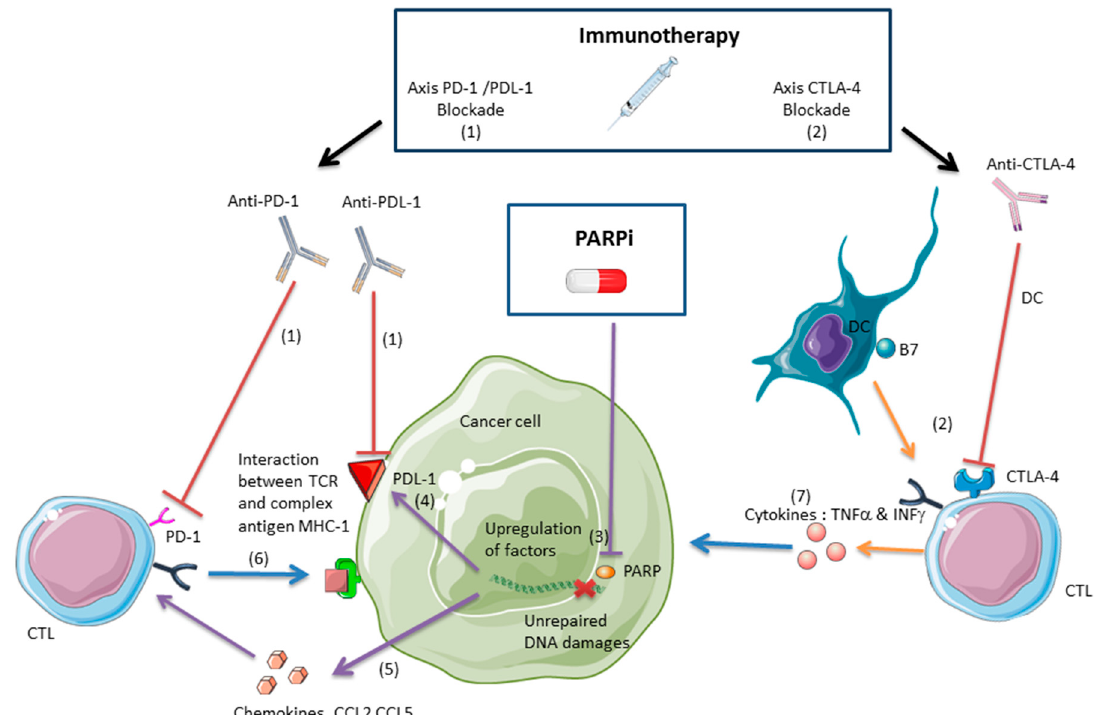
Figure 1. Poly(ADP-ribose) polymerase inhibitors (PARPis) and immune checkpoint inhibitors synergize and enhance an antitumor immune response mediated by specific activated CD8+ T lymphocytes against tumor antigens (CTLs). PARPis promote tumor-infiltrating lymphocytes (TILs) through the upregulation of chemokines and induce an immune response mediated by CTLs. However, PARPis induce the upregulation of PDL-1, inhibiting CTLs and promoting immune tumor escape. The anti-CTLA-4 immunotherapy activates T cells and can synergize with PARPis to induce an antitumor immune response. The anti-PDL-1/PD-1 immunotherapy can reverse the CTL inhibition mediated by the PDL-1 upregulation induced by PARPis. Thus, anti-PDL-1/PD-1 can synergize with PARPis to induce an antitumor immune response. [Arrows represent the activation or the induced expression processes of PARPi (violet), immune cells (orange), cytotoxicity (blue). T bars represent the inhibition processes of PARPi (violet) and immune check point inhibitors (red).]